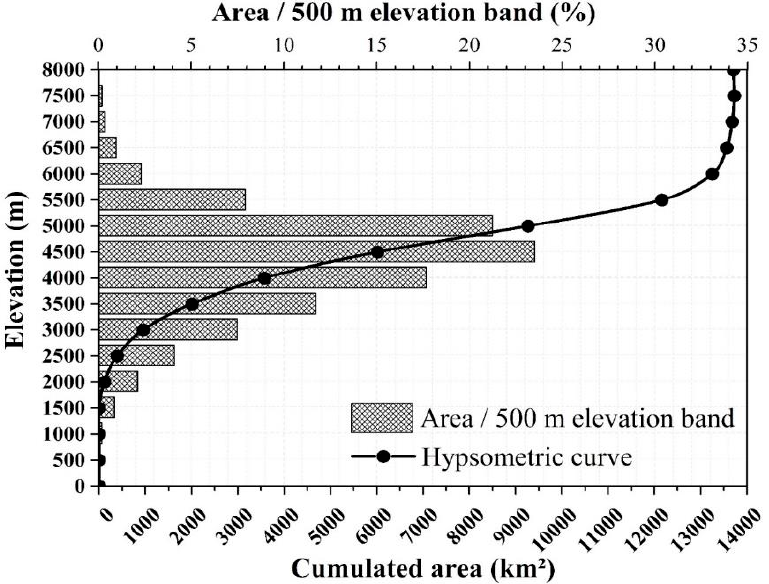
Figure 2. Elevation bands and Hypsometric curve of the study area.